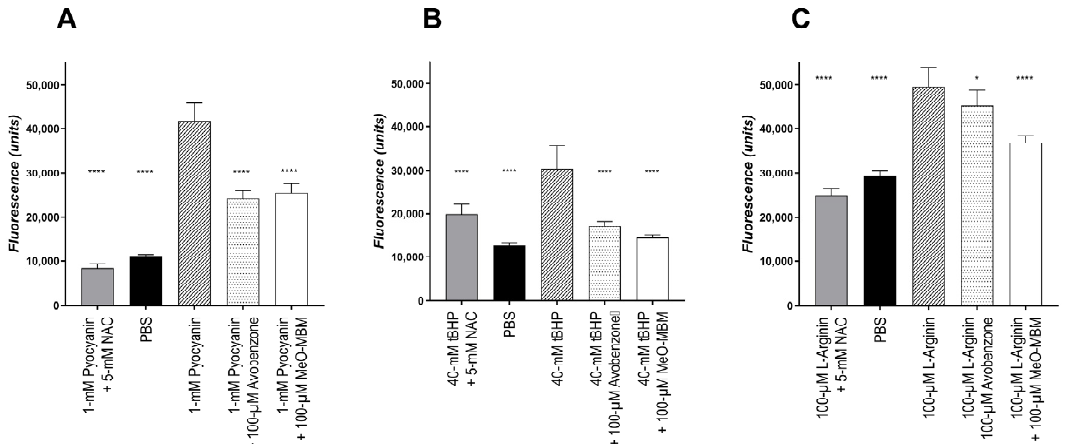
Figure 7. Cellular ROS/RNS scavenging capacity. The capability of avobenzone and MeO-MBM to scavenge intracellular ROS and RNS was assayed in HaCat. The cells were incubated with the test substances for 24 h; after which, stress was induced using ( A ) Pyocyanin as an inducer of ROS, superoxide radical ( B ) tBHP as an inducer for only ROS species, and ( C ) L -arginine as an inducer for RNS. As a negative control, N -acetyl-cystine was used. The significance was analyzed by one-way ANOVA with Dunnett’s multiple comparison test; *, p < 0.05 and ****, p < 0.001.